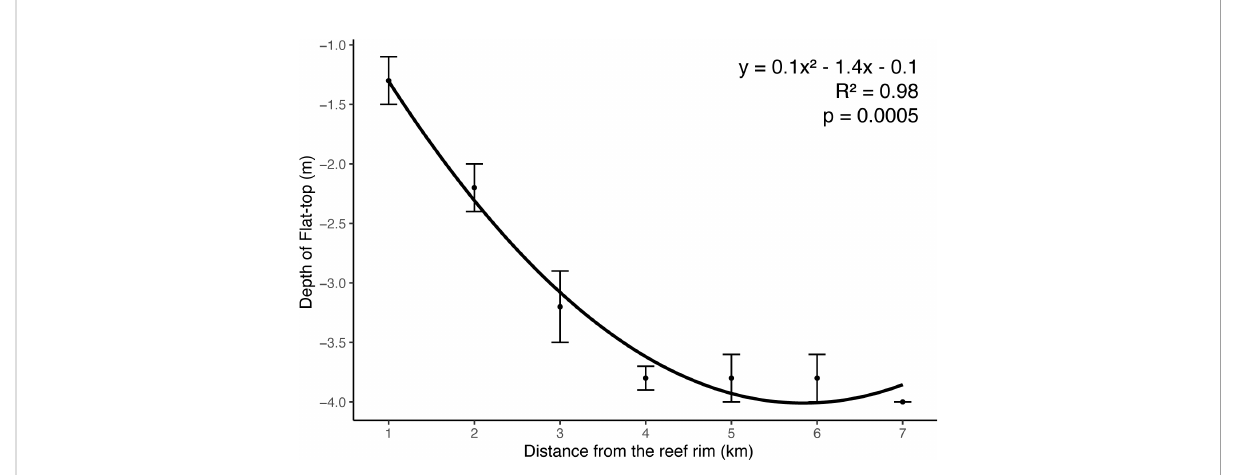
FIGURE 12 The quadratic regression showed the relationship between the depth of the top of the fl at-top patch reefs and the distance from the reef